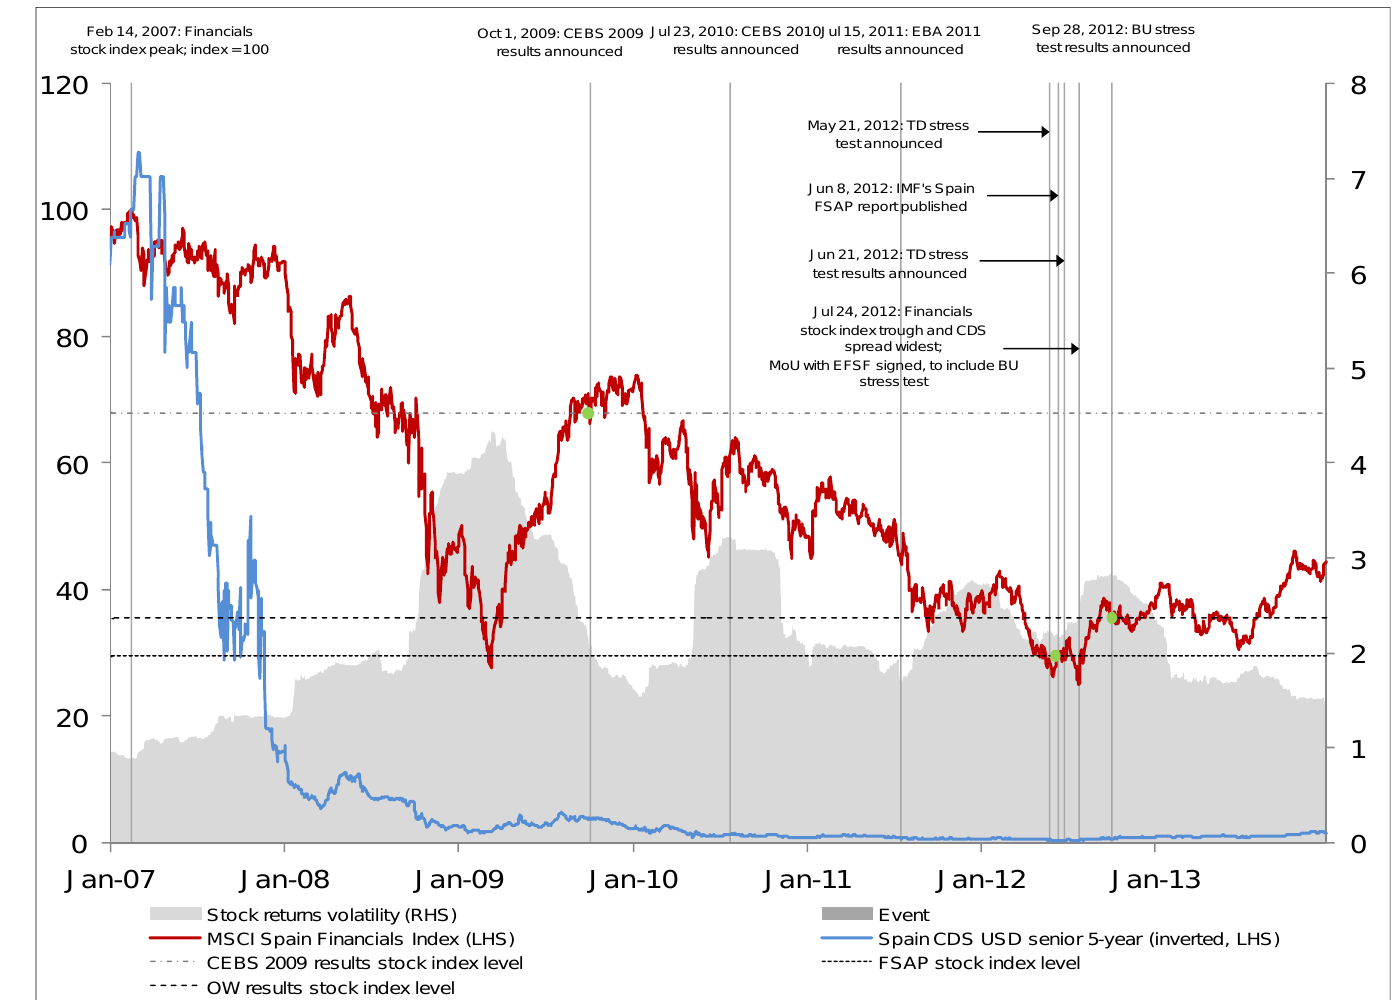
Figure 5. Spain: The “Floor” under the FSAP (Indexed to 100 on 14 February